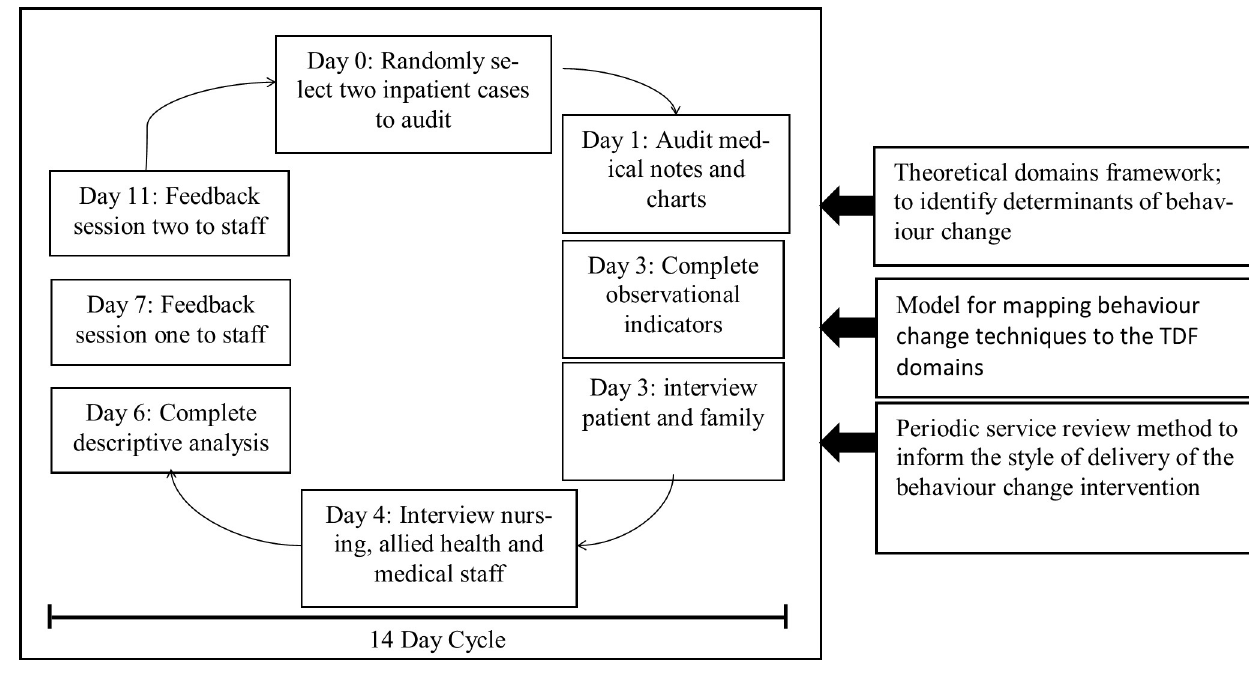
Fig 2. Flow of fortnightly